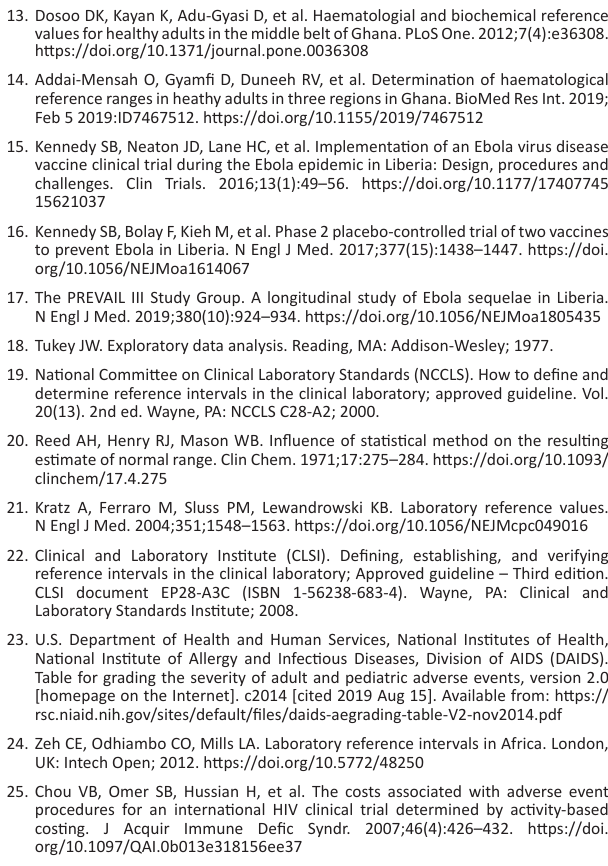
Table for grading the severity of adult and pediatric adverse events, version 2.0 [homepage on the Internet]. c2014 [cited 2019 Aug 15]. Available from: